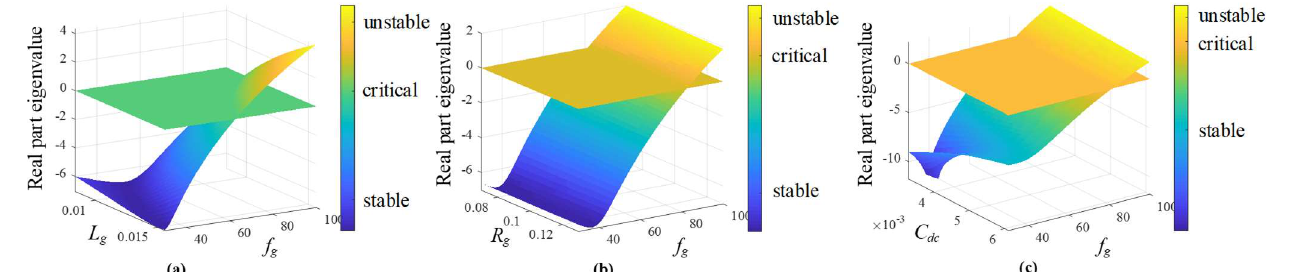
Figure 5. The imaginary closest eigenvalue evolution as a function of parameters with frequency (from 30 to 100 Hz). ( a ) L g from 70% to 130% with respect the nominal value; ( b ) R g from 70% to 130% with respect the nominal value; ( c ) C dc from 70% to 130% with respect the nominal value. As aforementioned, high frequencies lead some eigenvalues to reach positive real values, making the closed loop system unstable, as confirmed in the next section. The